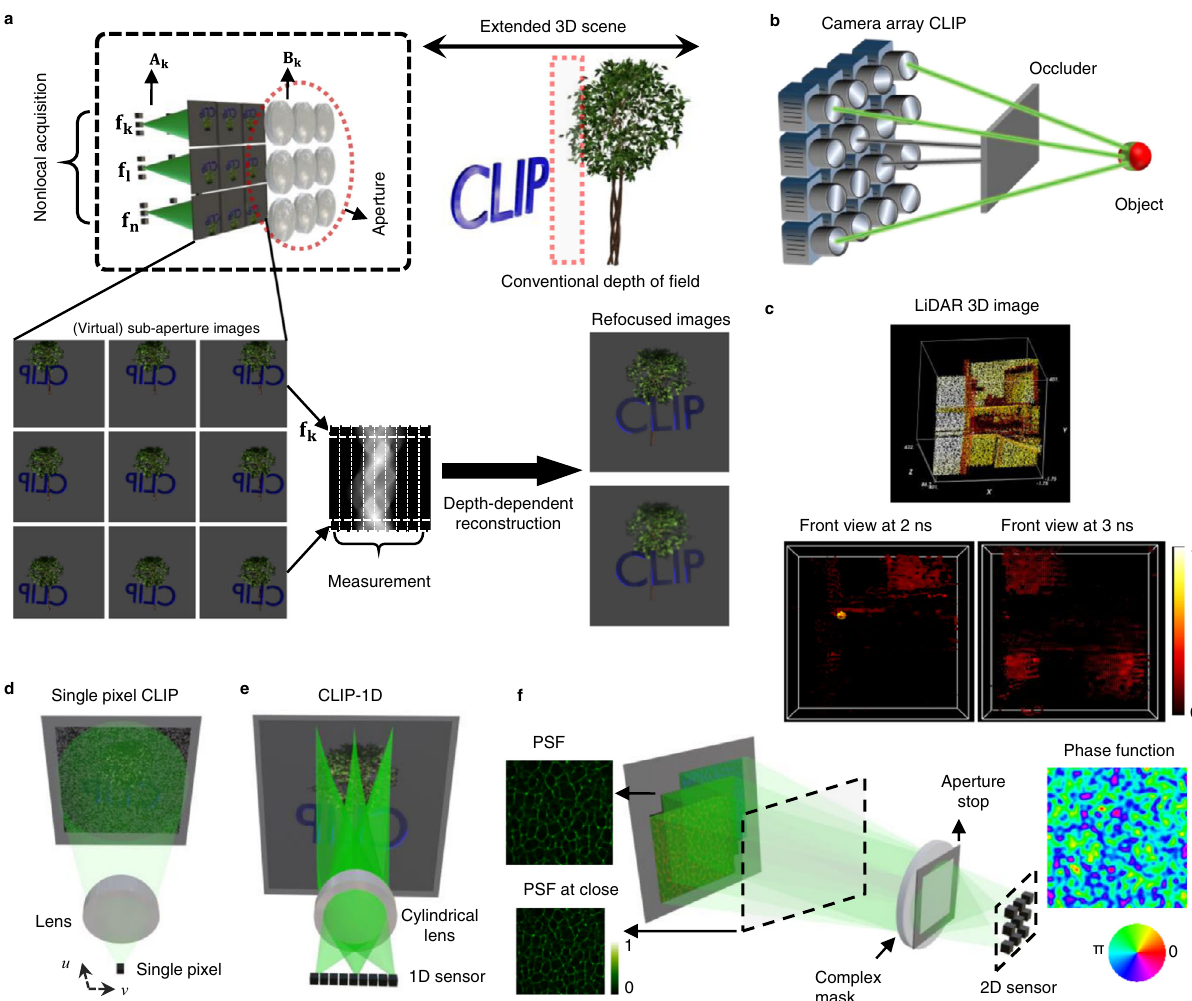
Fig. 1 Principle of compact light fi eld photography. a A conventional light fi eld camera captures the scene from different views with a lens array and records all sub-aperture images. In contrast, CLIP records (operator A k ) only a few nonlocal measurements ( f k to f n ) from each sub-aperture image and exploits the depth-dependent disparity (modeled by B k ) to relate the sub-aperture images for gathering enough information to reconstruct the scene computationally. Refocusing is achieved by varying the depth-dependent disparity model B k . b Seeing through severe occlusions by CLIP as a camera array, with each camera only recording partial nonlocal information of the scene. A obscured object (from the camera with black rays) remains partially visible to some other views (with green rays), whose nonlocal and complementary information enables compressive retrieval of the object. c Illustration of instantaneous compressibility of the time-of- fl ight measurements for a 3D scene in a fl ash LiDAR setup, where a transient illumination and measurement slice the crowded 3D scene along the depth (time) direction into a sequence of simpler instantaneous 2D images. d – f CLIP embodiments that directly perform nonlocal image acquisitions with a single-pixel, a linear array, and 2D area detectors, respectively. A single pixel utilizes a defocused spherical lens to integrate a coded image, with u and v behind the lnes being the angular dimension. A cylindrical lens yields along its invariant axis a radon transformation of the en-face image onto a 1D sensor. The complex-valued mask such as a random lens produces a random, wide- fi eld PSF that varies with object depth to allow light fi eld imaging. PSF point spread function, CLIP compact light fi eld photography, LiDAR light detection and ranging, 1D, 2D, 3D one, two, and